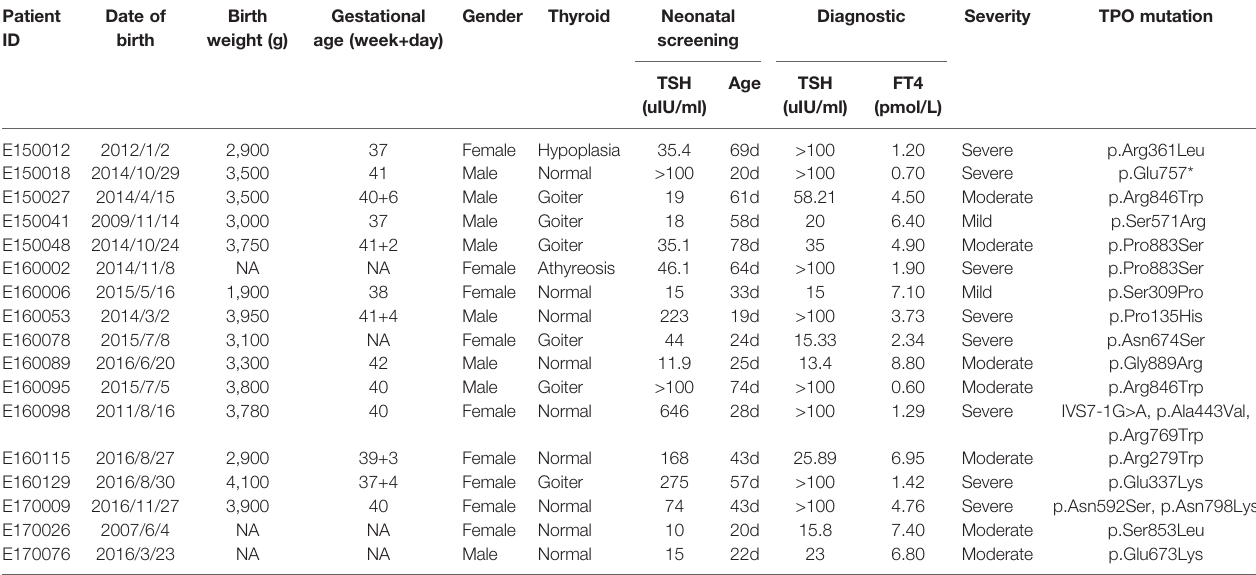
TABLE 1 | Clinical information of CH patients with TPO